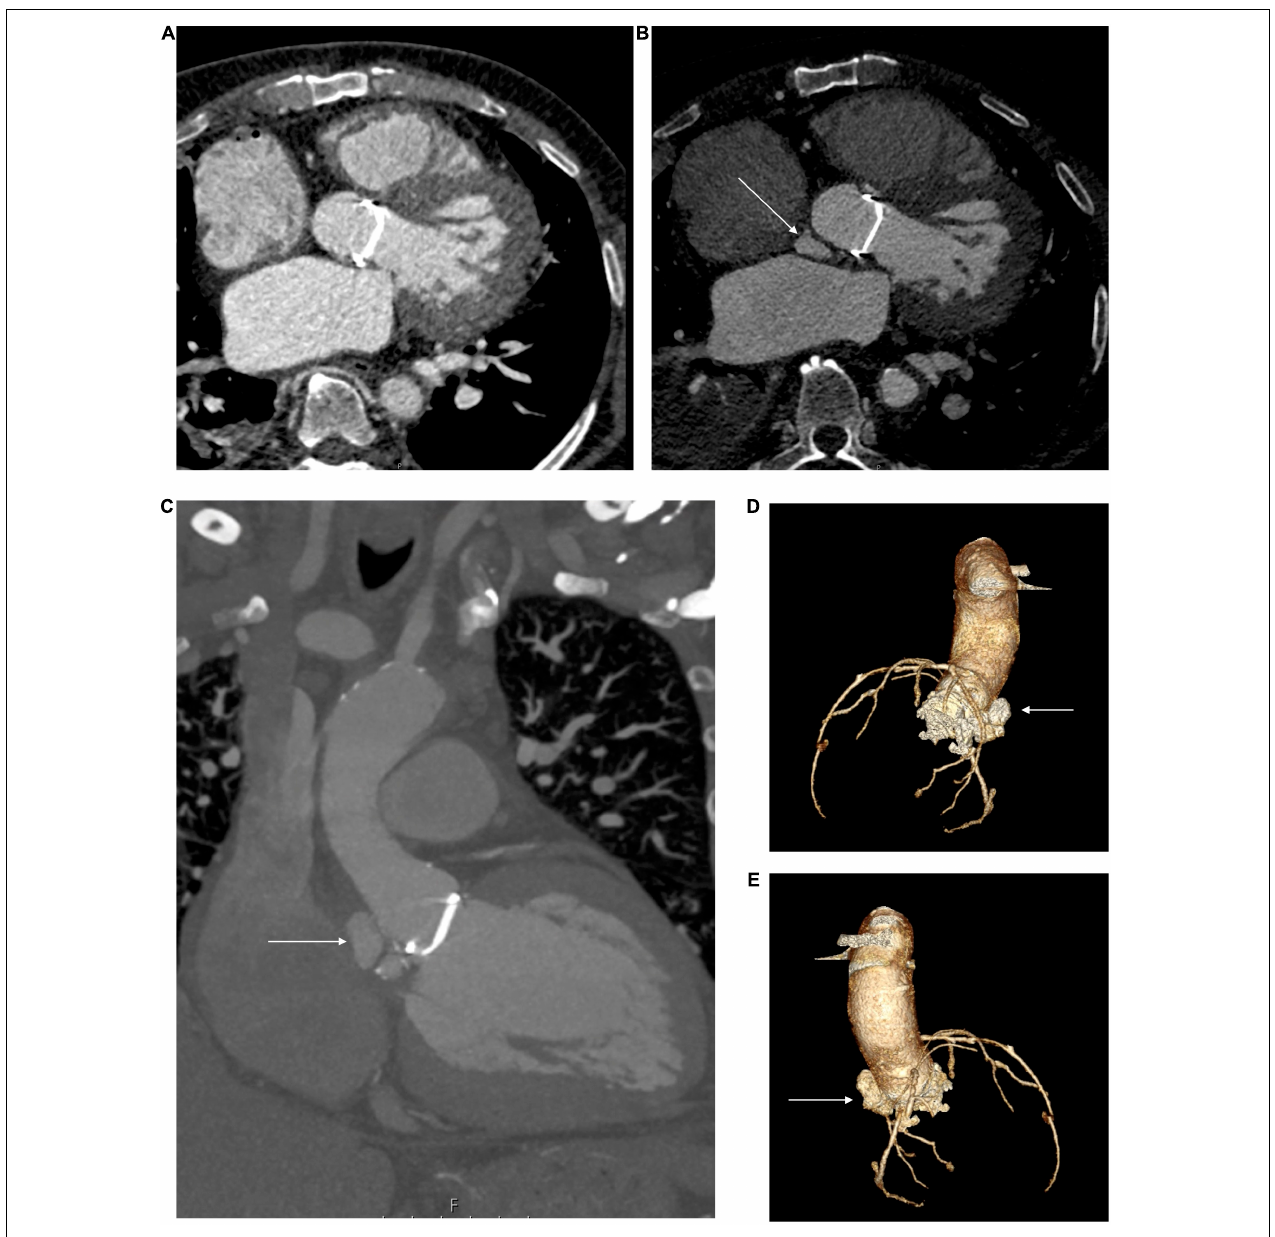
FIGURE 5 | Aortic root abscess seen in a patient with a previous metallic surgical aortic valve implanted in 2010. An axial slice from 2013 without an abscess (A) , and a similar slice from 2017 showing a root abscess indicated by a white arrow (B) . A coronal view (C) and 3D reconstructions (D,E) illustrate the abscess indicated by the white